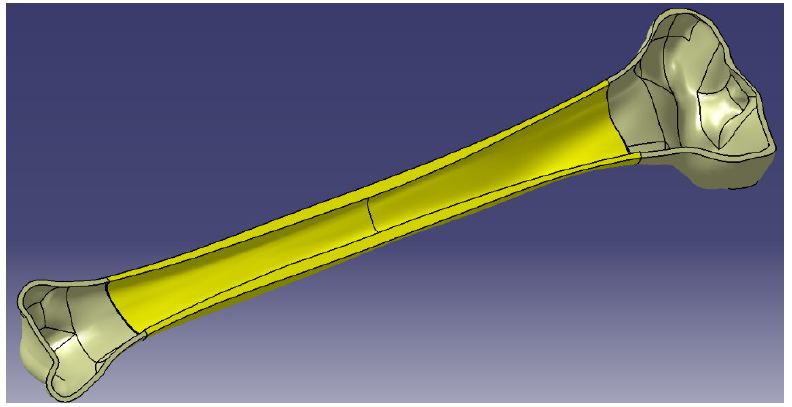
Figure 4. Section of human tibia—cortical bone.